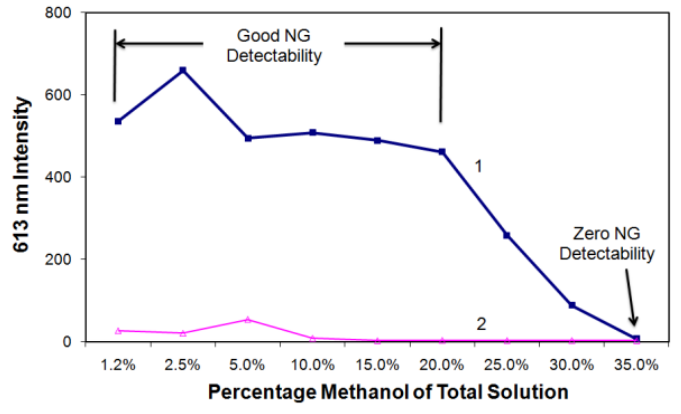
FIGURE 4 . Eu/TTA 613-nm emission as a function of methanol percentage (1) with NG (10 – 3 M ) and (2) without